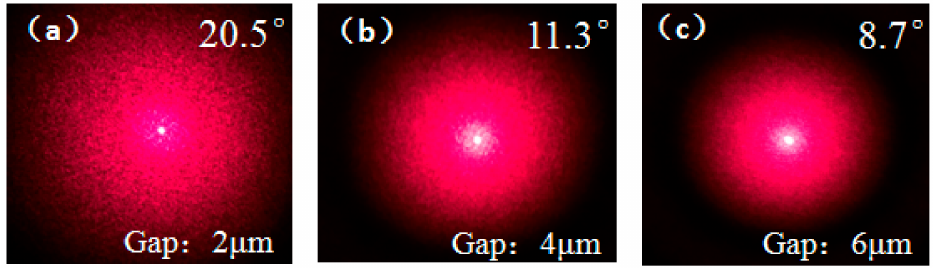
Figure 10. The scattering speckle patterns produced by the mask with different sizes of gaps: ( a ) 2 µ m; ( b ) 4 µ m; ( c ) 6 µ m.